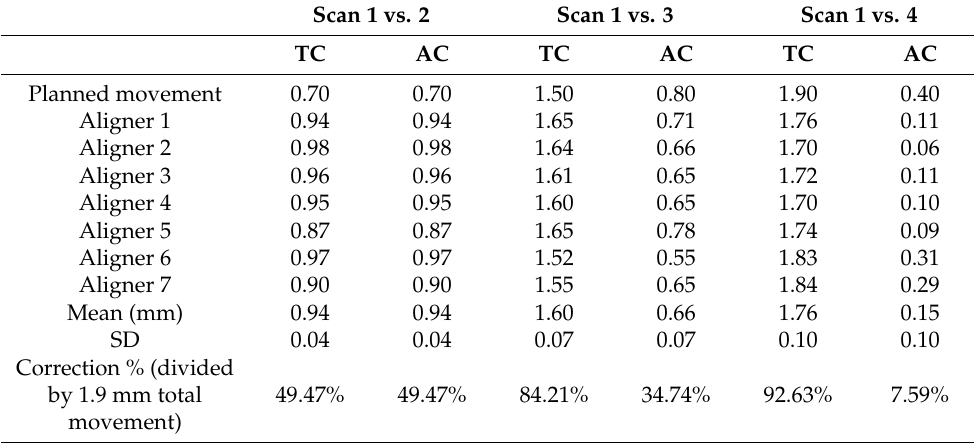
Table 2. Mean and standard deviation (SD) of the total cumulative correction (TC) of the position of the upper left central incisor tooth after superimposition of each step’s scan over the scan of the initial mal-position, the added correction (AC) after superimposition of each step’s scan over its predecessor step’s scan, and the percentage of correction efficiency by the ClearX aligner.